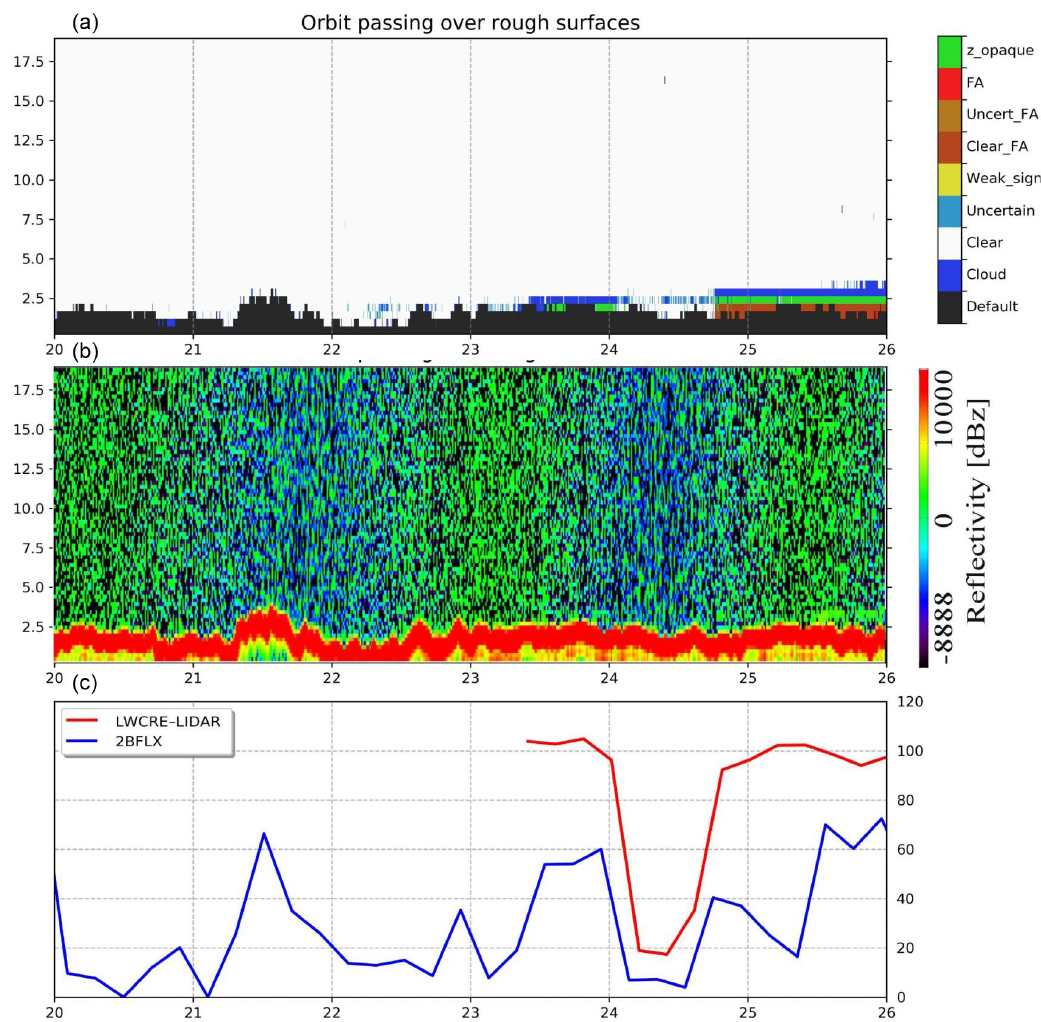
Figure B2. Same as Fig. B1 but for a piece of orbit passing over China on 10 November 2008 at 18:58:39LST.